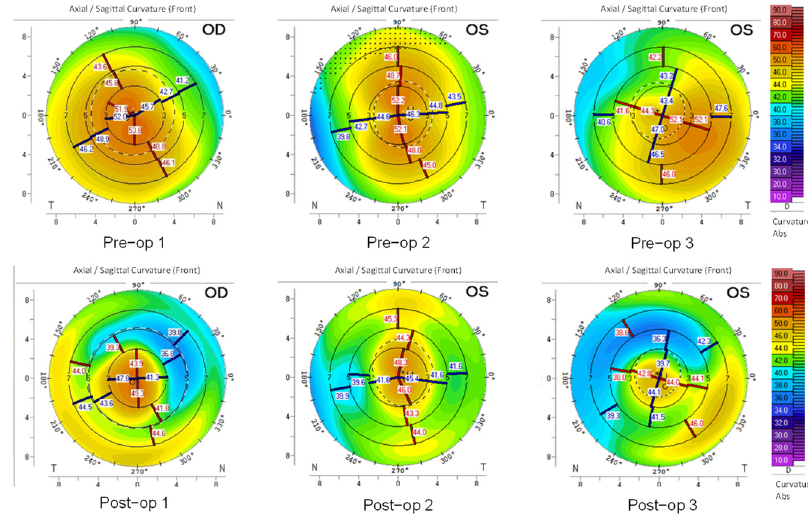
Figure 3. The curvature (CURV) maps based on Pentacam-derived topometric data for three repre- sentatives of the KCN group within 8 mm diameter of the corneas (the horizontal and the vertical axis). The color-coded scale is identical in all images.